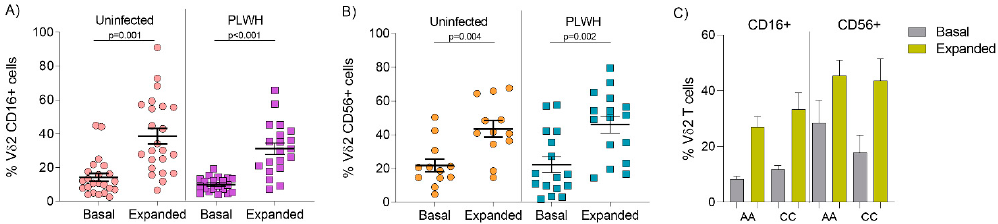
Figure 1. Expression of CD16 and CD56 on V δ 2 cells prior to and post PAM-expansion in uninfected donors and PLWH on ART. Comparable mean expression of basal ( A ) CD16 and ( B ) CD56 on V δ 2 cells between uninfected and PLWH and after seven days of exposure to PAM and IL-2, p = 0.42 and p = 0.43, respectively, Mann Whitney U-test. Both uninfected and PLWH increased CD16 and CD56 expression upon expansion ( p < 0.001 and p < 0.001, respectively, Wilcoxon matched pairs signed rank test). ( C ) Similar distribution of basal and expanded mean CD16 expression on V δ 2 cells from nine African American (AA) and ten Caucasian (CC) PLWH donors ( p = 0.08 and p = 0.60, respectively, Mann Whitney U-test). Comparable mean basal and expanded CD56 expression on V δ 2 cells in six AA and ten CC donors ( p = 0.26 and p = 0.84, respectively, Mann Whitney U-test).